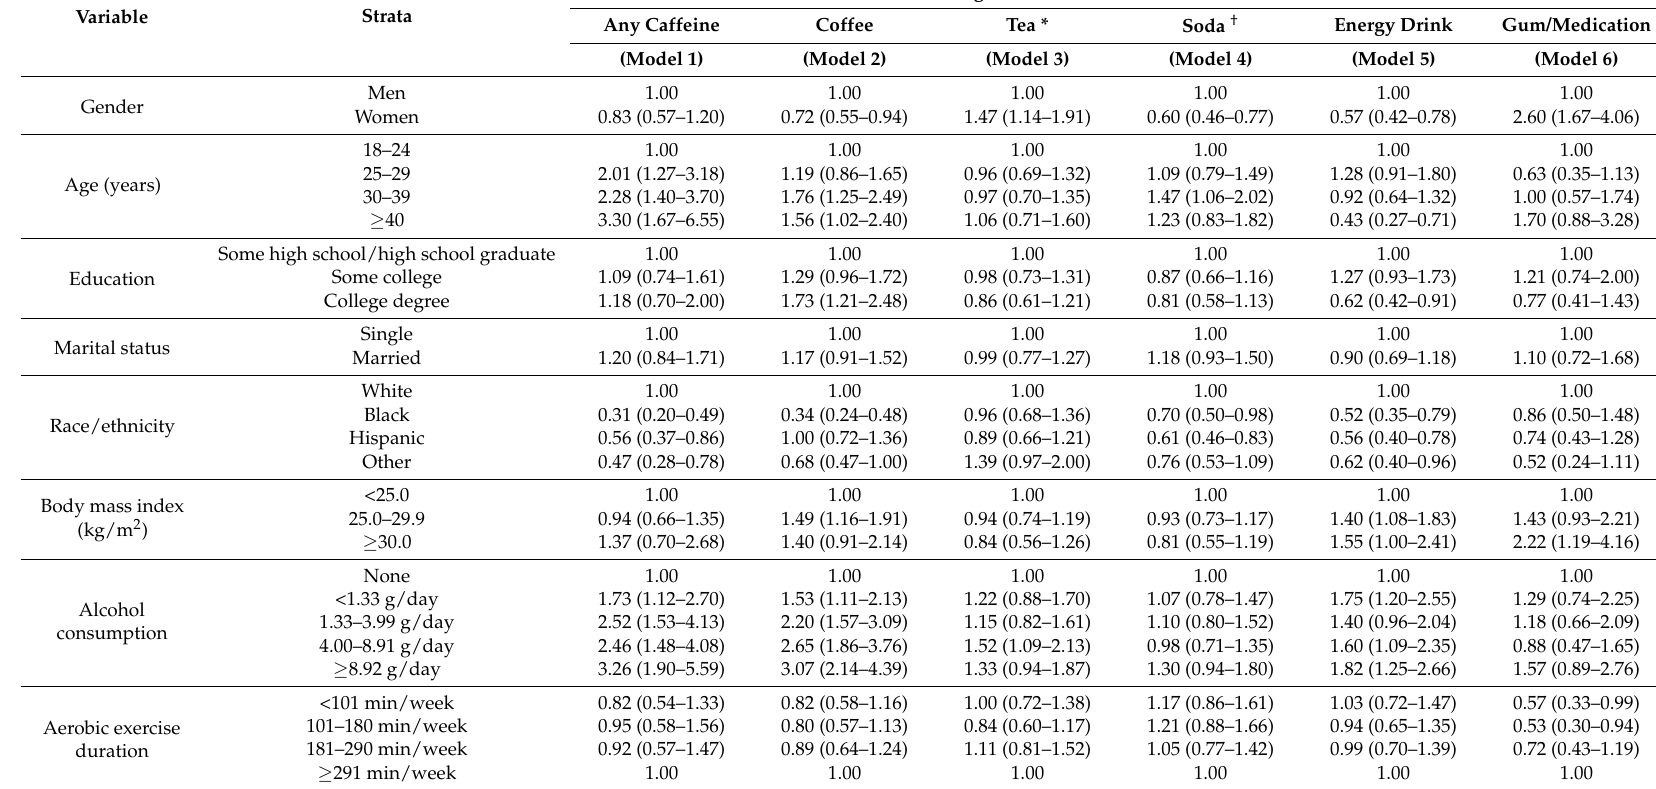
Table 4. Characteristics associated with use ( ≥ 1 time/week) of specific caffeine products among Navy and Marine Corps personnel. Multivariable logistic regression was used. Data are presented as odds ratios adjusted for other factors listed with 95% confidence intervals. The odds ratio 1.00 represents the reference group for each